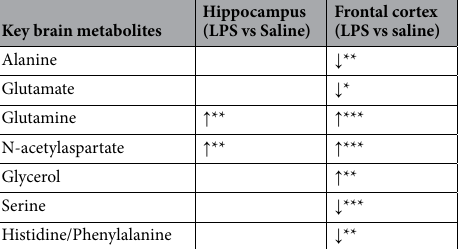
Table 2. Summary of the key aqueous-phase metabolites driving the discrimination between LPS and saline treatment groups, and their direction of change compared to saline. * p < 0.05; ** p < 0.01; *** p < 0.001.